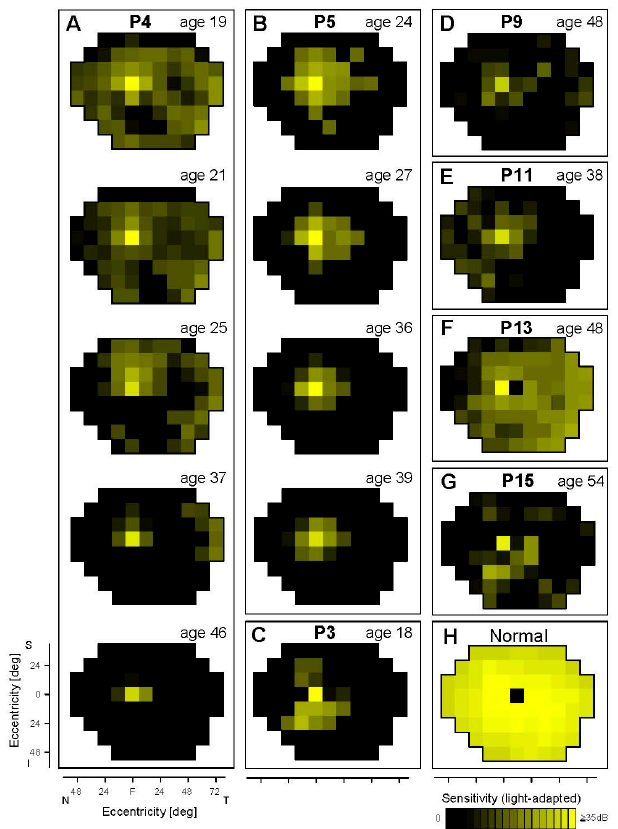
Figure 1. Cone sensitivity across the visual field in EYS patients. Light-adapted perimetry results of seven patients are shown as maps ( A – G ). P4 ( A ) and P5 ( B ) have serial maps from visits spanning decades. Normal cone sensitivity is shown for reference ( H ). The physiological blind spot is represented as a black square at 12° in the temporal field. N, nasal; T, temporal; S, superior; I, inferior visual field.